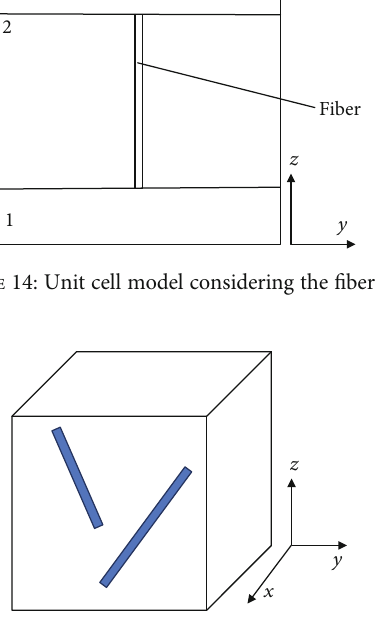
Figure 15: Unit cell model of fi ber position relationship.